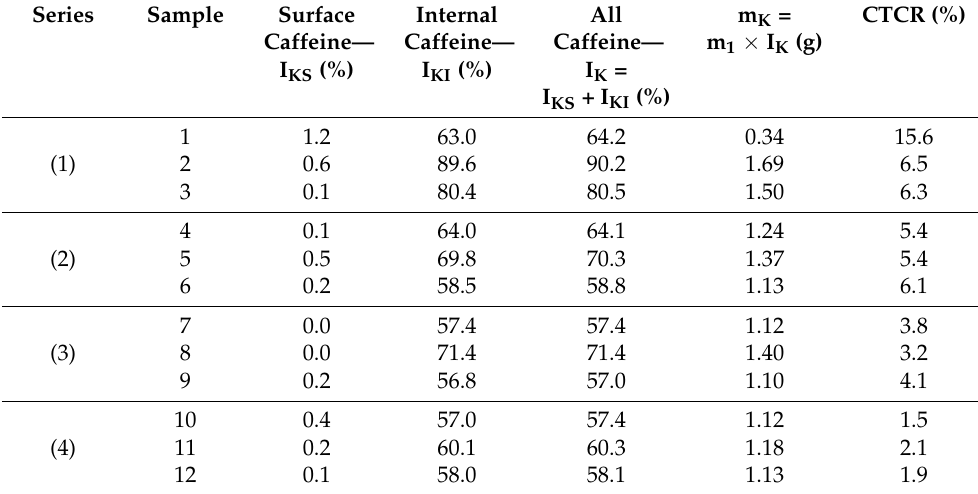
Table 6. Percentage of caffeine on the surface and in the volume of the sample, and caffeine mass determined from